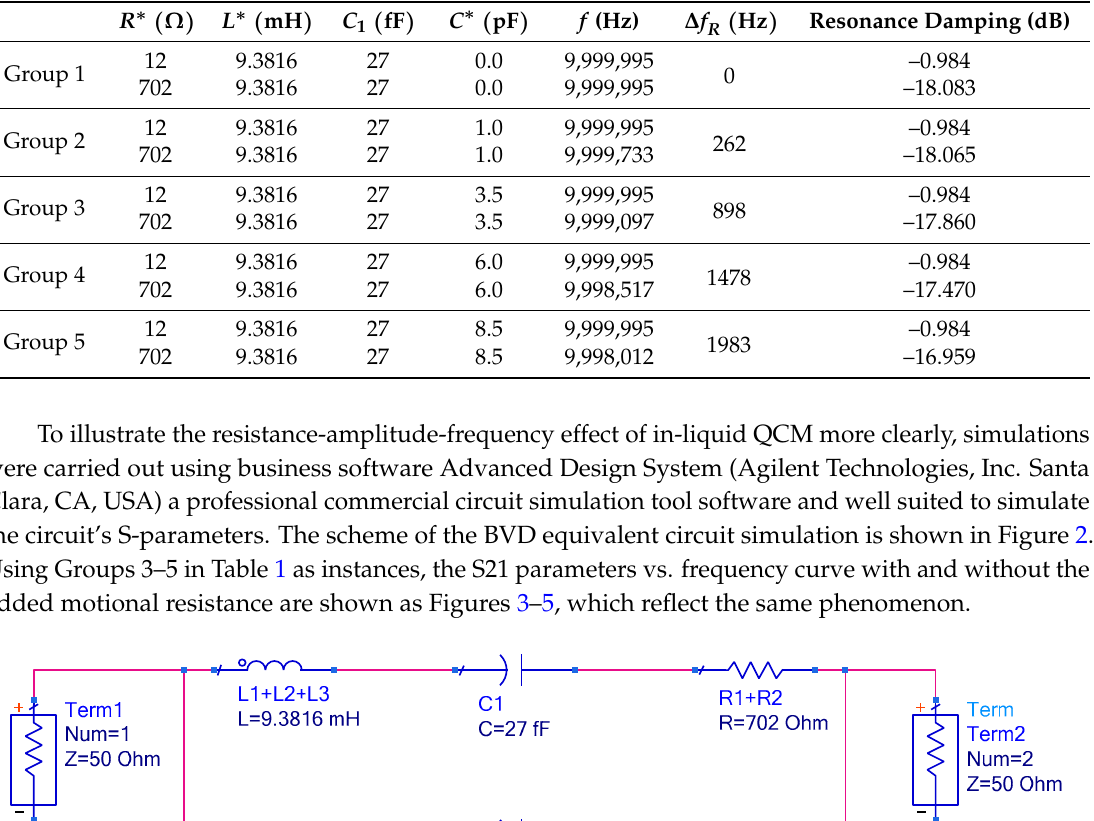
Table 1. The calculated results using the BVD equivalent circuit model.